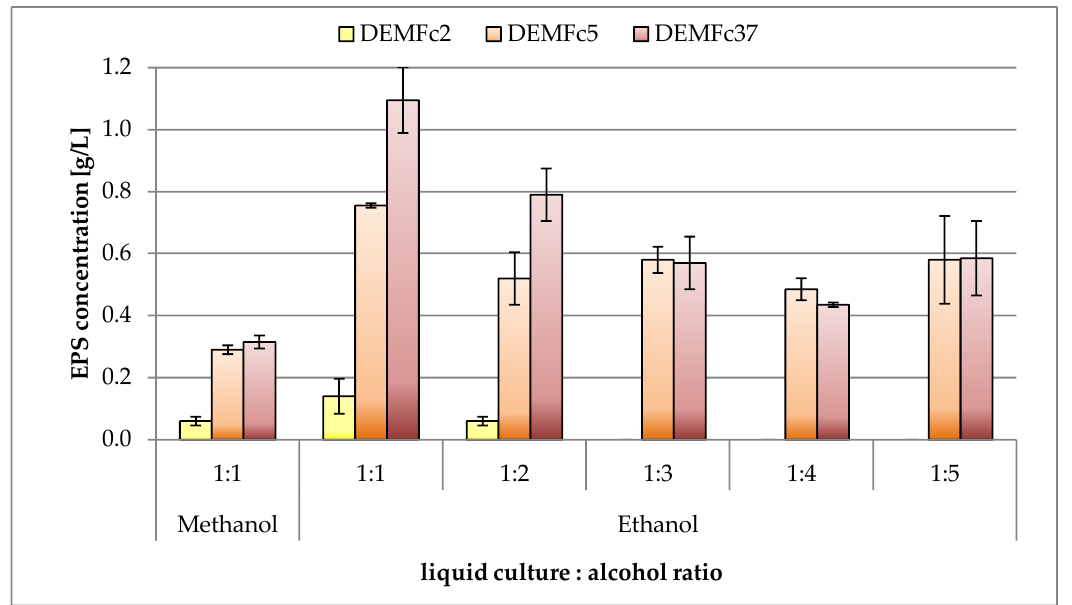
Figure 3. EPS precipitation procedure using different alcohols (methanol, ethanol) and different liquid culture:alcohol ratio.